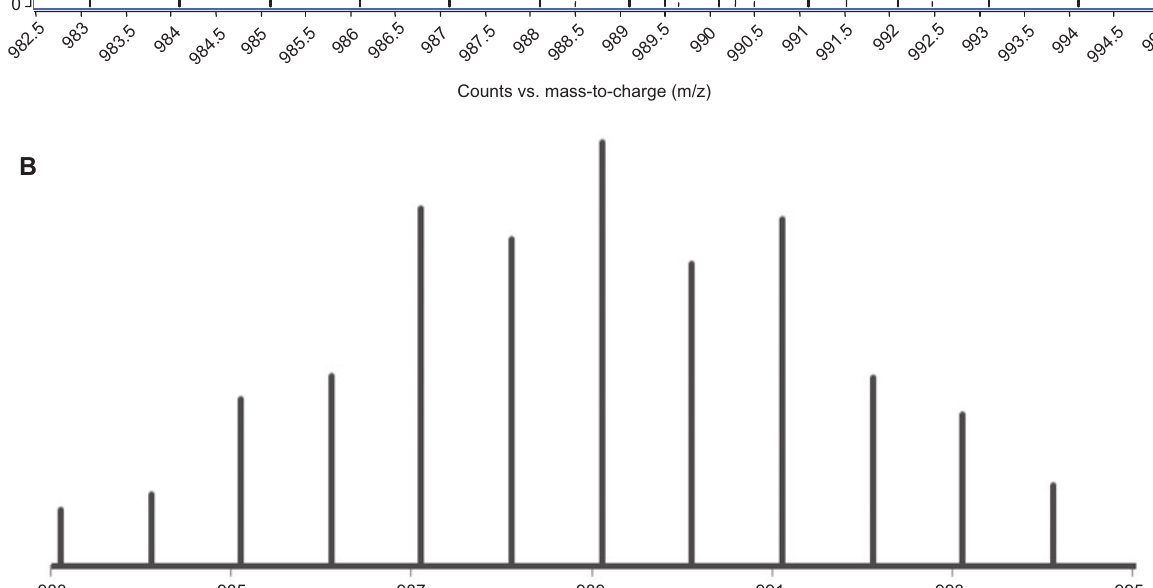
H O Sn ] + and the simulated spectrum 51 43 6 2